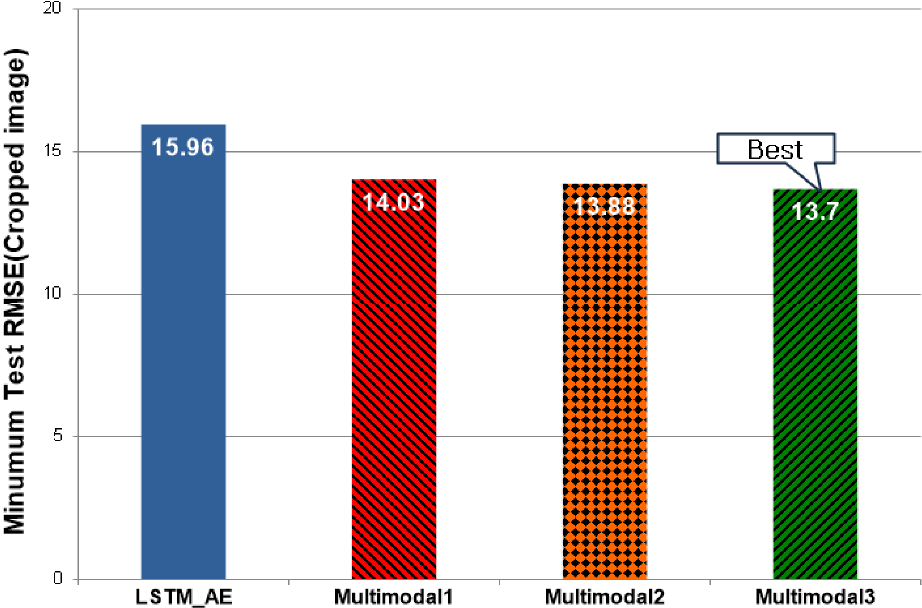
Figure 11. Minimum Test RMSE for each model using the cropped image.